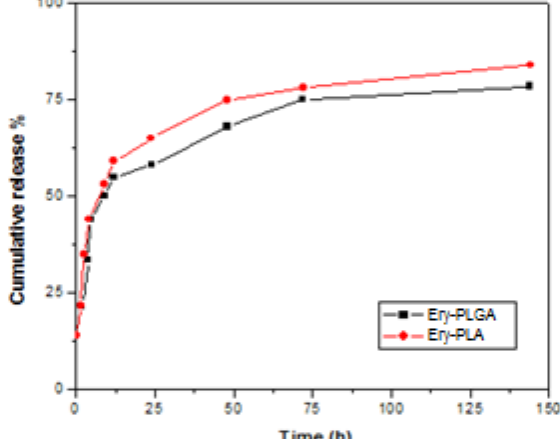
Figure 8. In vitro antibiotic release out of Ery ‐ PLA/Ery ‐ PLGA nanoparticles.